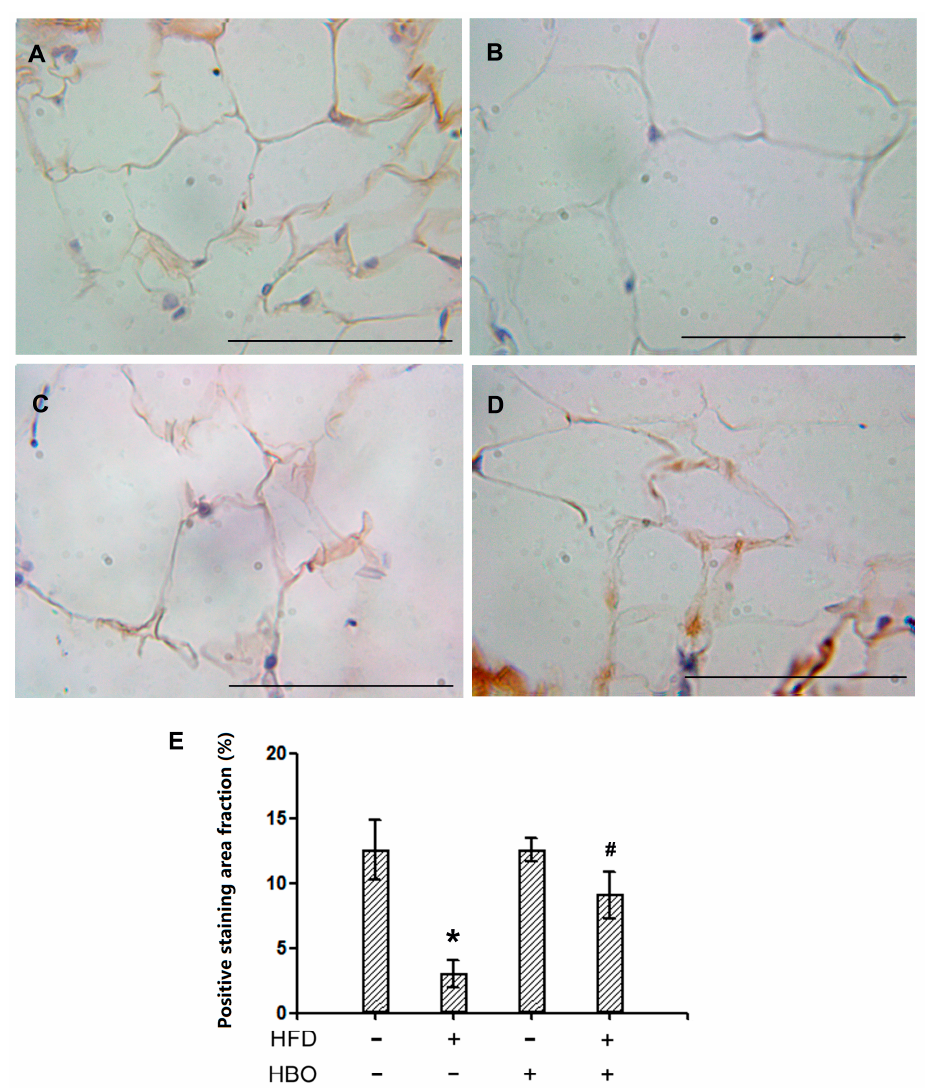
Figure 4. Immunohistochemistry for hormone-sensitive lipase (HSL) on EWAT. EWAT tissues were fixed in 4% paraformaldehyde for 24 h, and then histologically processed and sectioned at thickness of 6 um. ImmunohistochemistryforHSLwasperformedfollowingmanufacturer’sinstructions. Quantificationwas performed with ImageJ. Three samples from three independent animals were assessed per group. Error barsrepresentstandardderivation. Scalebarsrepresent70um. ( A